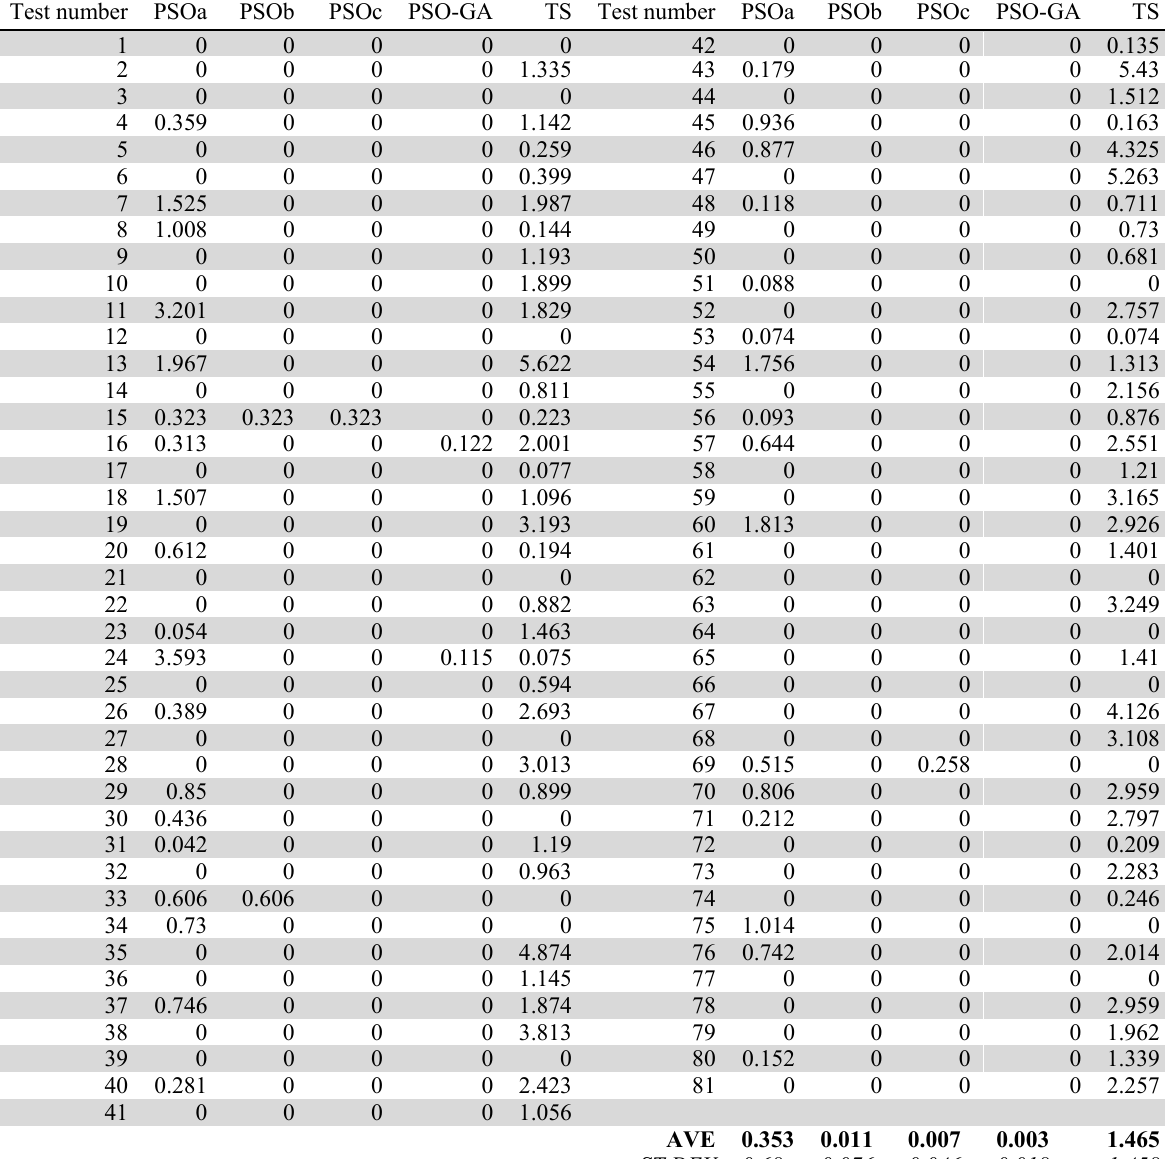
Small-sized problems: average RPD results over the two